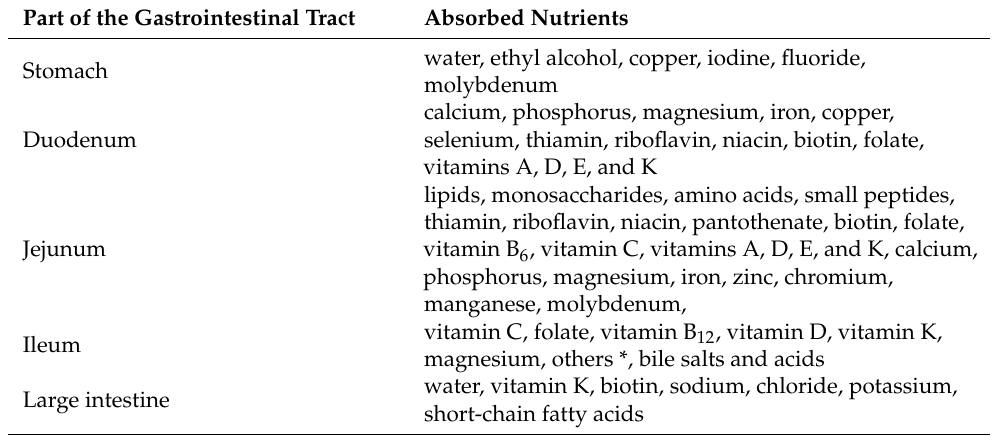
Table 1. Sites of absorption of nutrients in the intestine